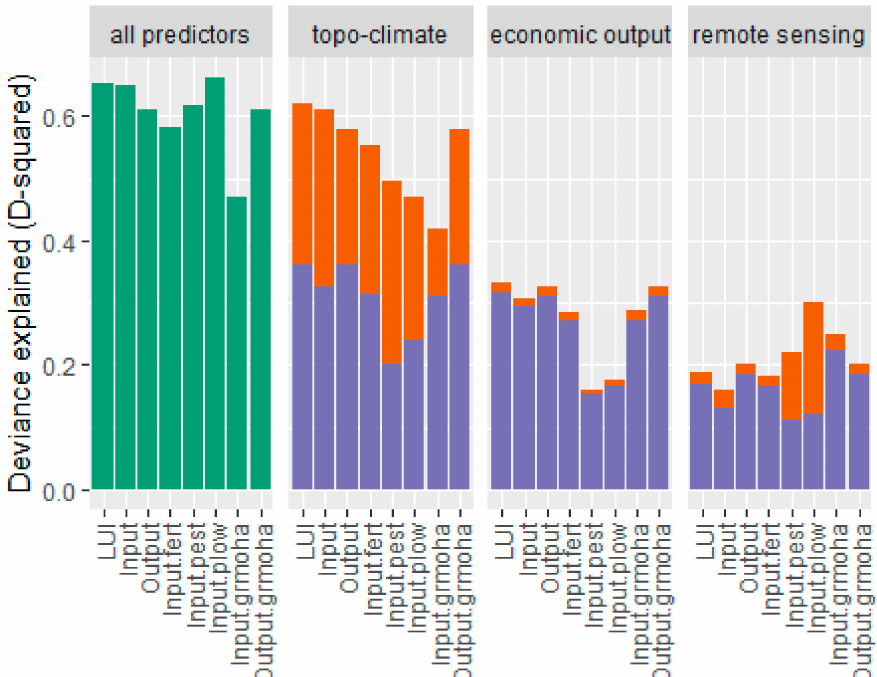
Figure 4. Deviance explained by the full model (green), the individual contribution (orange) and the joint contribution (violet) of the topo-climatic predictors, the economic output predictors, and the remote-sensing predictors, where LUI = LUI index; Input = the input dimension of the LUI; Output = the output dimension of the LUI; Input fert = fertiliser input; Input.pest = pesticide input; Input.plow = ploughing; Input.grmoha = grazing, mowing, and harvesting; and Output.grmoha = biomass output by grazing, mowing, and